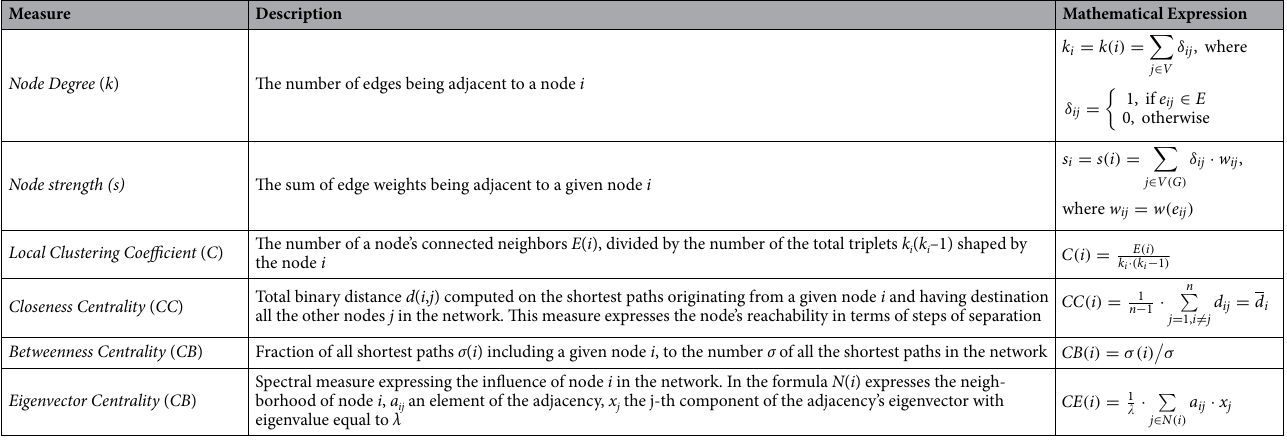
Table 1. The node measures that are considered in the analysis